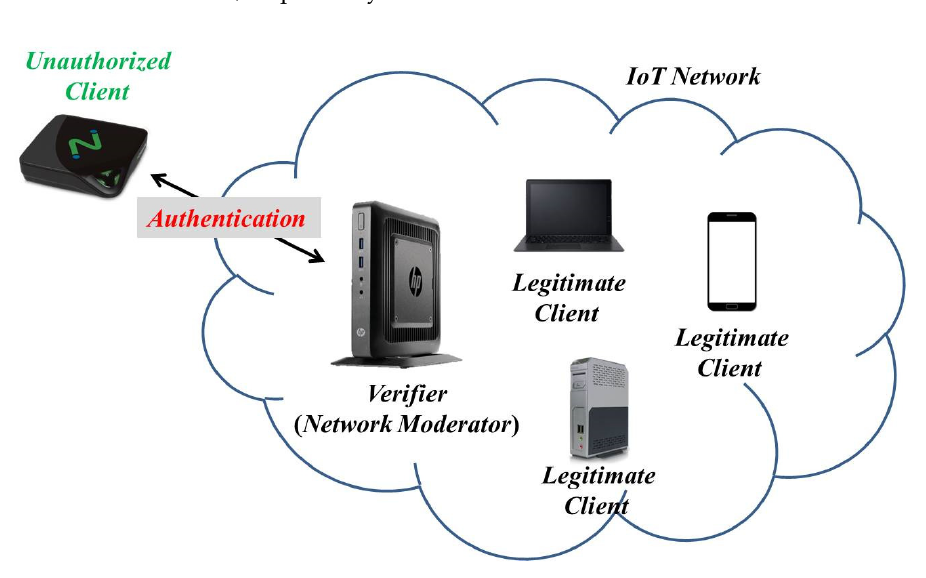
Figure 2. System